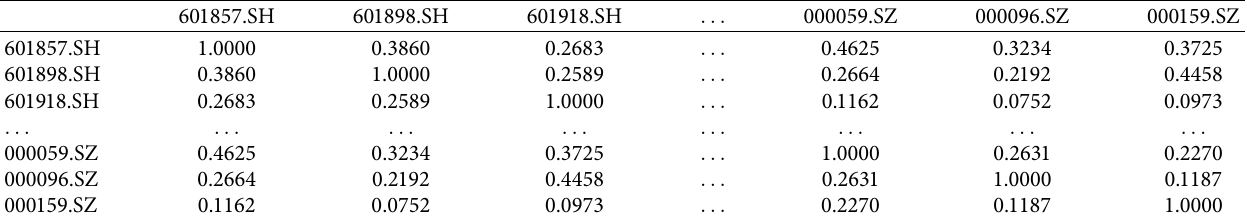
Table 4: Jump correlation coefficient matrix from October 2016 to April